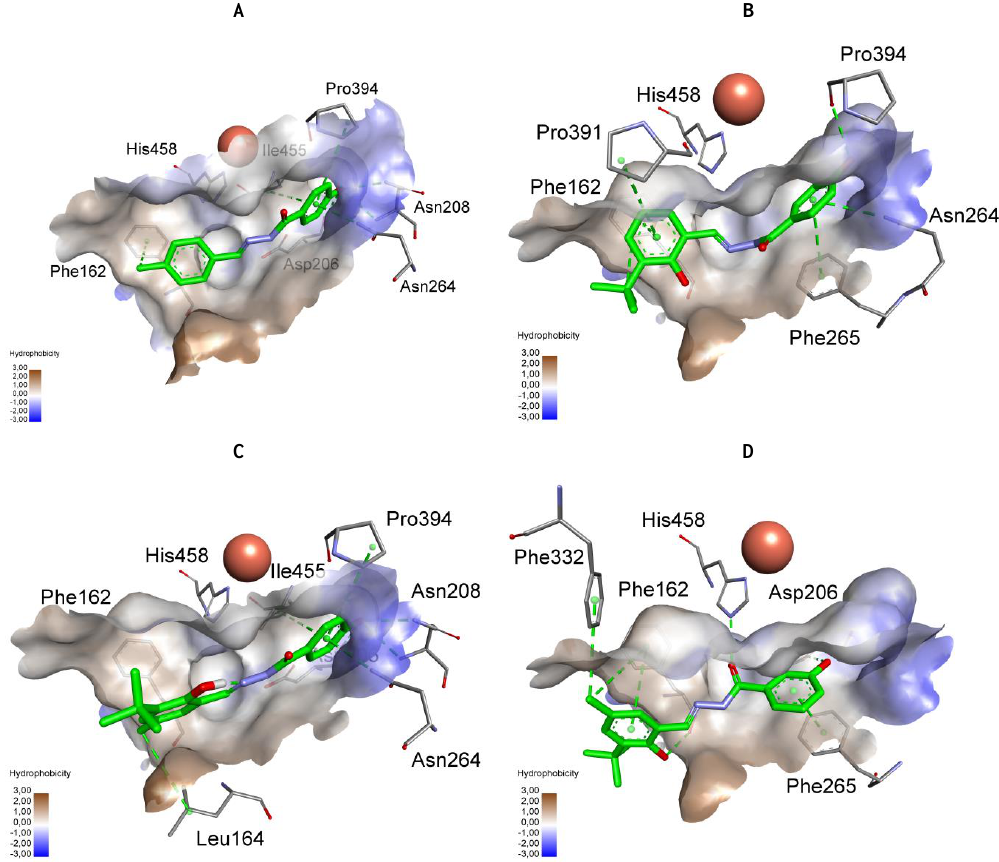
Figure 5. The representation of 1c ( A ), 2b ( B ), 3d ( C ), 3g ( D ) compounds interactions in the active site of laccase from Trametes versicolor (PDB: 1GYC). The copper ions are shown as orange spheres. A surface of the enzyme ( A – D ) represents the hydrophobicity of nearby amino acid side chains. A